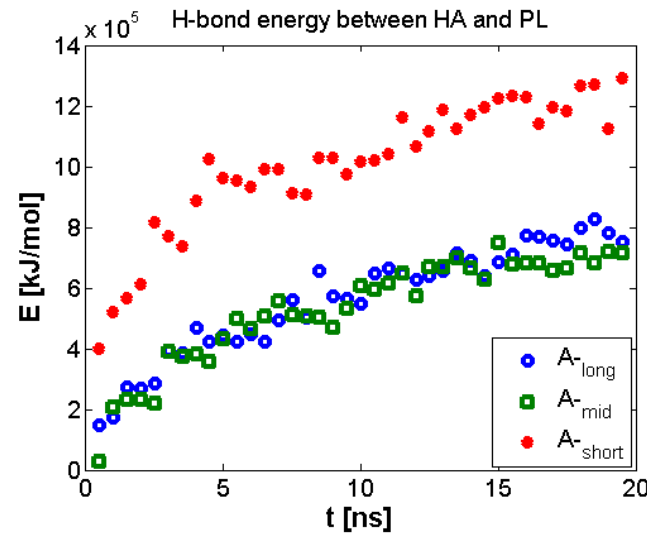
Figure 9. Normalized H-bonds energy between (A-) chains for all lengths with phospholipid.